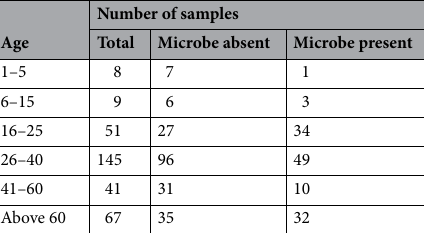
Table 3. Prevalence of microorganisms among age